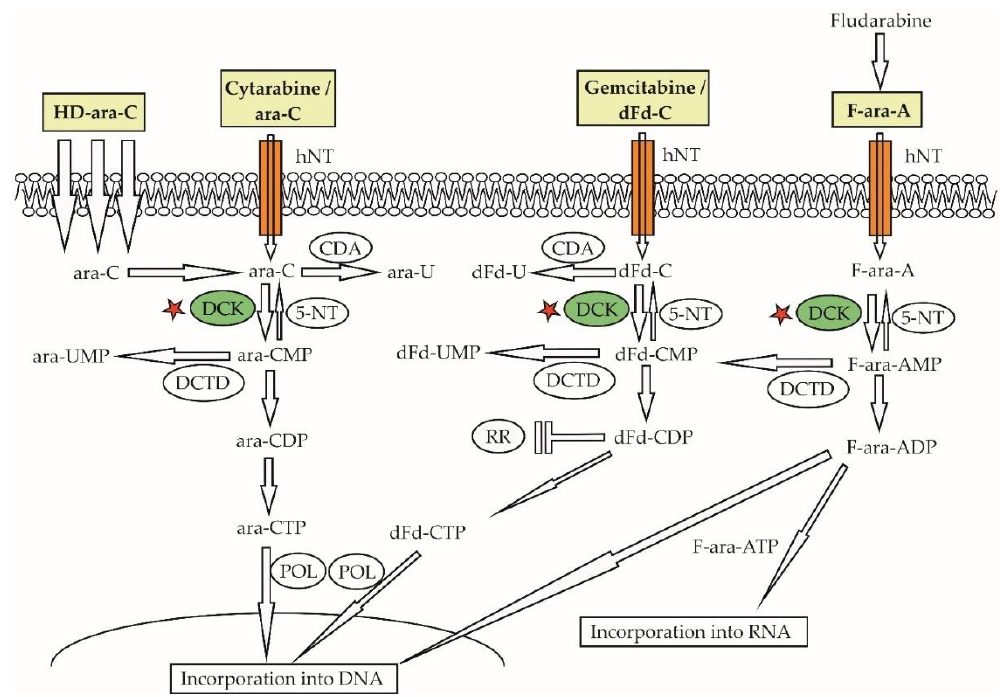
Figure 6. Downregulation of deoxycytidine-kinase confers resistance to a broad range of antinucleosides .